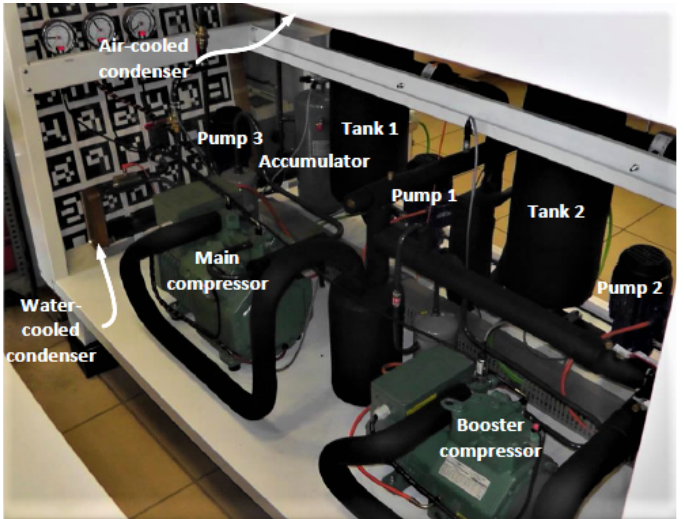
Figure 1. Laboratory version of the chiller used at the installation producing the E2 data-set.